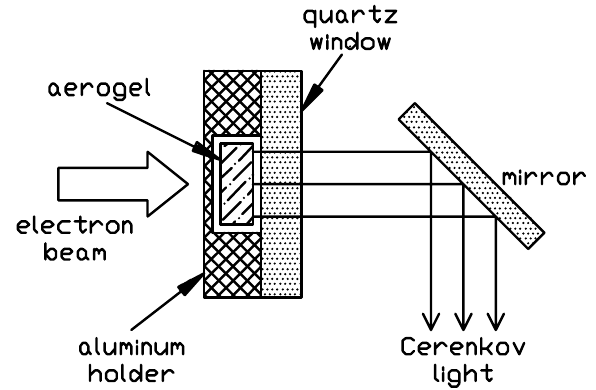
FIG. 2. Schematic of the aerogel holder, indicating the propa- gation of the electron beam and Cerenkov light. 041302-2